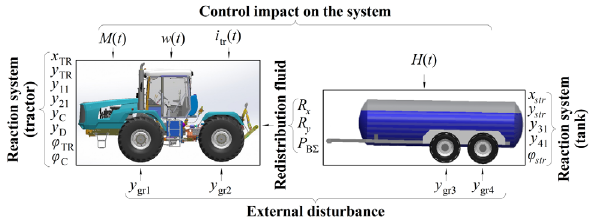
Fig. 1. Calculation scheme of the model in the longitudinal plane: y 11 , y 21 , y C , y D , y TR – vertical movement of the tractor axles, cabins, driver’s seat and tractor frame; y 31 , y 41 , y str – vertical movement of axles frames of the tank; φ TR , φ C , φ str – tilt angle of tractor frame, cab and tank;